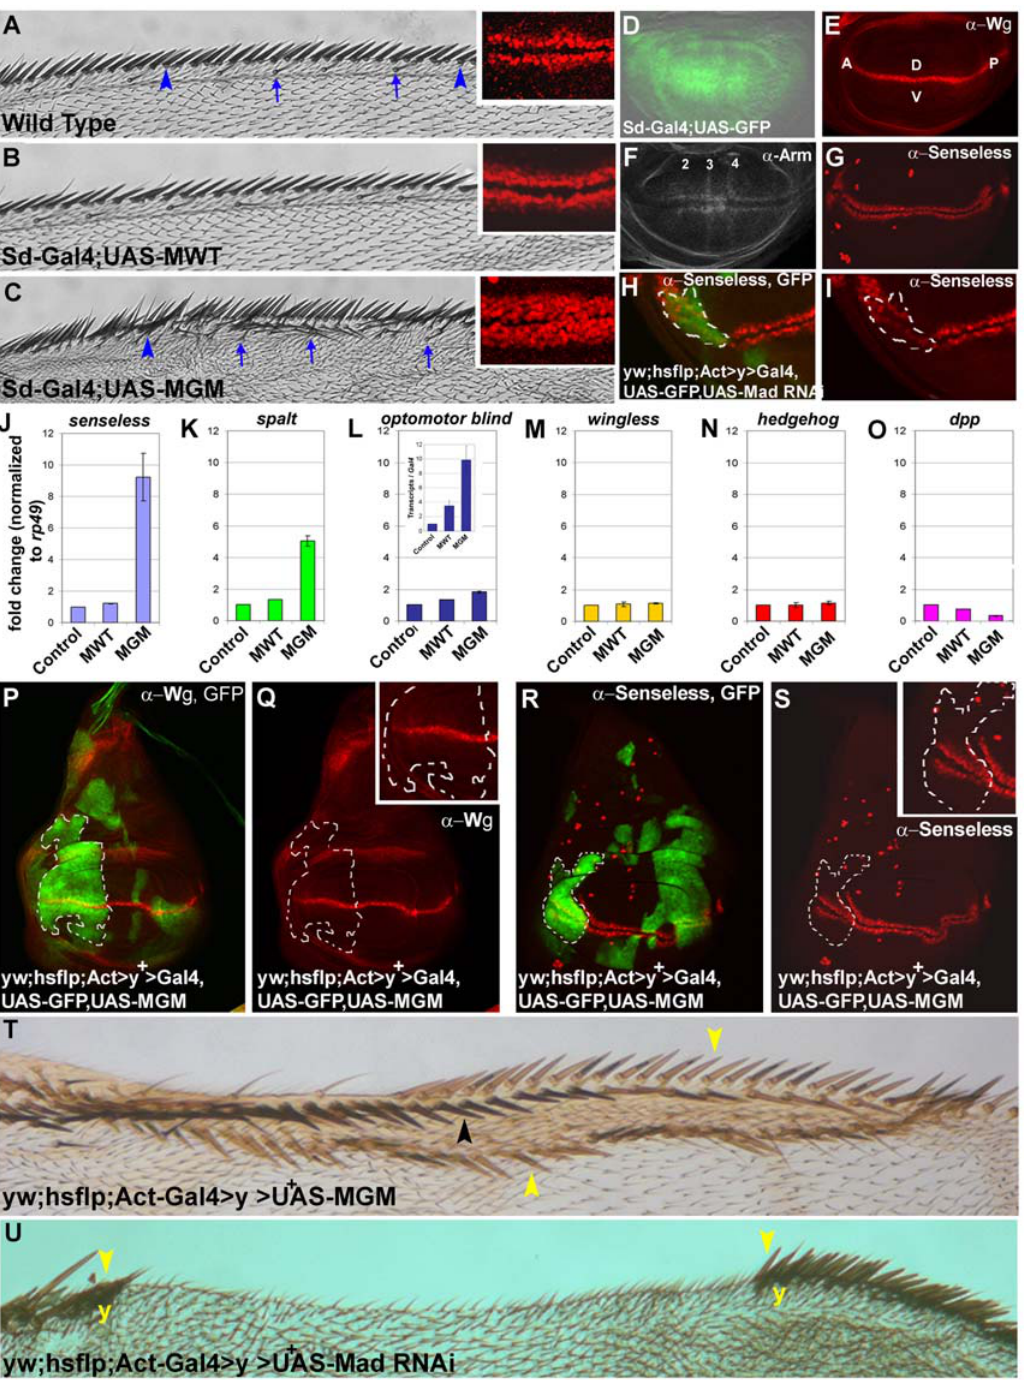
Figure 2. Mad GSK3 Mutants Mimic Wg Overexpression. (A–C) Additional bristles are induced in the wing margin by MGM driven by scalloped-Gal4. Arrows indicate chemosensory bristles and arrowheads stout mechanosensory bristles. Insets show that the number of Senseless- expressing bristle precursors in wing imaginal discs is increased by MGM, but not MWT.(D–G) Expression domains of sd-Gal4 driver, Wg protein, Armadillo stabilized by Wg (expression in the proveins is noted), and Senseless in wing discs. (H and I) Senseless protein expression was inhibited in Mad RNAi clones marked by GFP. (J–O) Quantitative RT-PCR of wing discs showing that MGM increased both a Wg target gene ( senseless ) and Dpp target genes ( spalt and optomotor blind ), while not affecting wg or hh levels. dpp was inhibited by MGM RNA. Samples were normalized for rp49 , except for the inset in L in which Gal4 mRNA was used. (P and Q) Clonal overexpression of MGM does not change Wg levels. (R and S) MGM clone in the anterior margin causes ectopic expression of Senseless within the clone (inset). (T) Overexpression of MGM in clones marked by yellow induced duplications of the wing margin (n=24). Yellow arrowheads indicate ectopic margins and a black arrowhead the wild type one. (U) Knockdown of Mad in clones partially eliminates the wing margin In this large clone the remaining margin bristles are yellow ( y ).